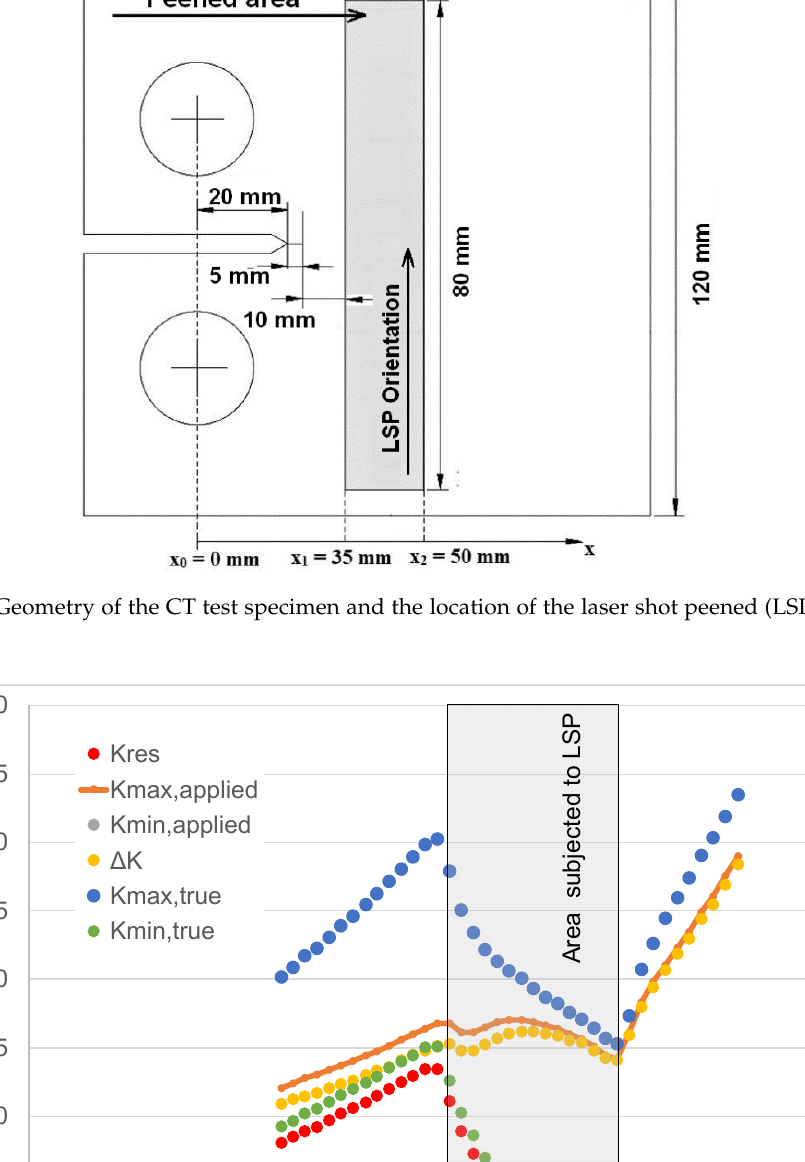
Figure 7. The relationship between an effective R ratio ( R true ) and the crack length for the LSP study reported in [75]. Before we could compute the effect of the residual stress on crack growth, we needed the constants D, p and A in Equations (1) and (2) for this thickness material. These constants— D = 1.8 × 10 − 9 , p = 2 and A = 45 MPa √ m—were obtained from R = 0.5 and 0.05 crack growth data that were obtained from the NASGRO database. To do this, we represented the crack growth data by plotting da/dN against Δκ ; see Figure 8. The values of ∆ K thr , D , A and p used in this analysis are given in Table 1.